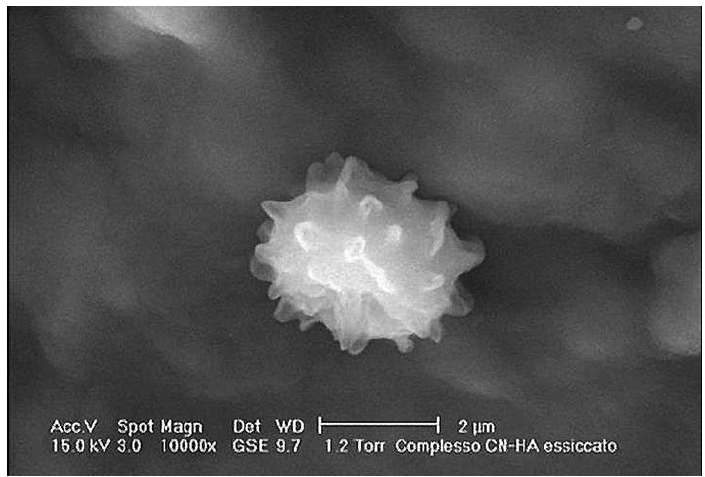
Figure 2. Nanoparticles of CN-HA at SEM.